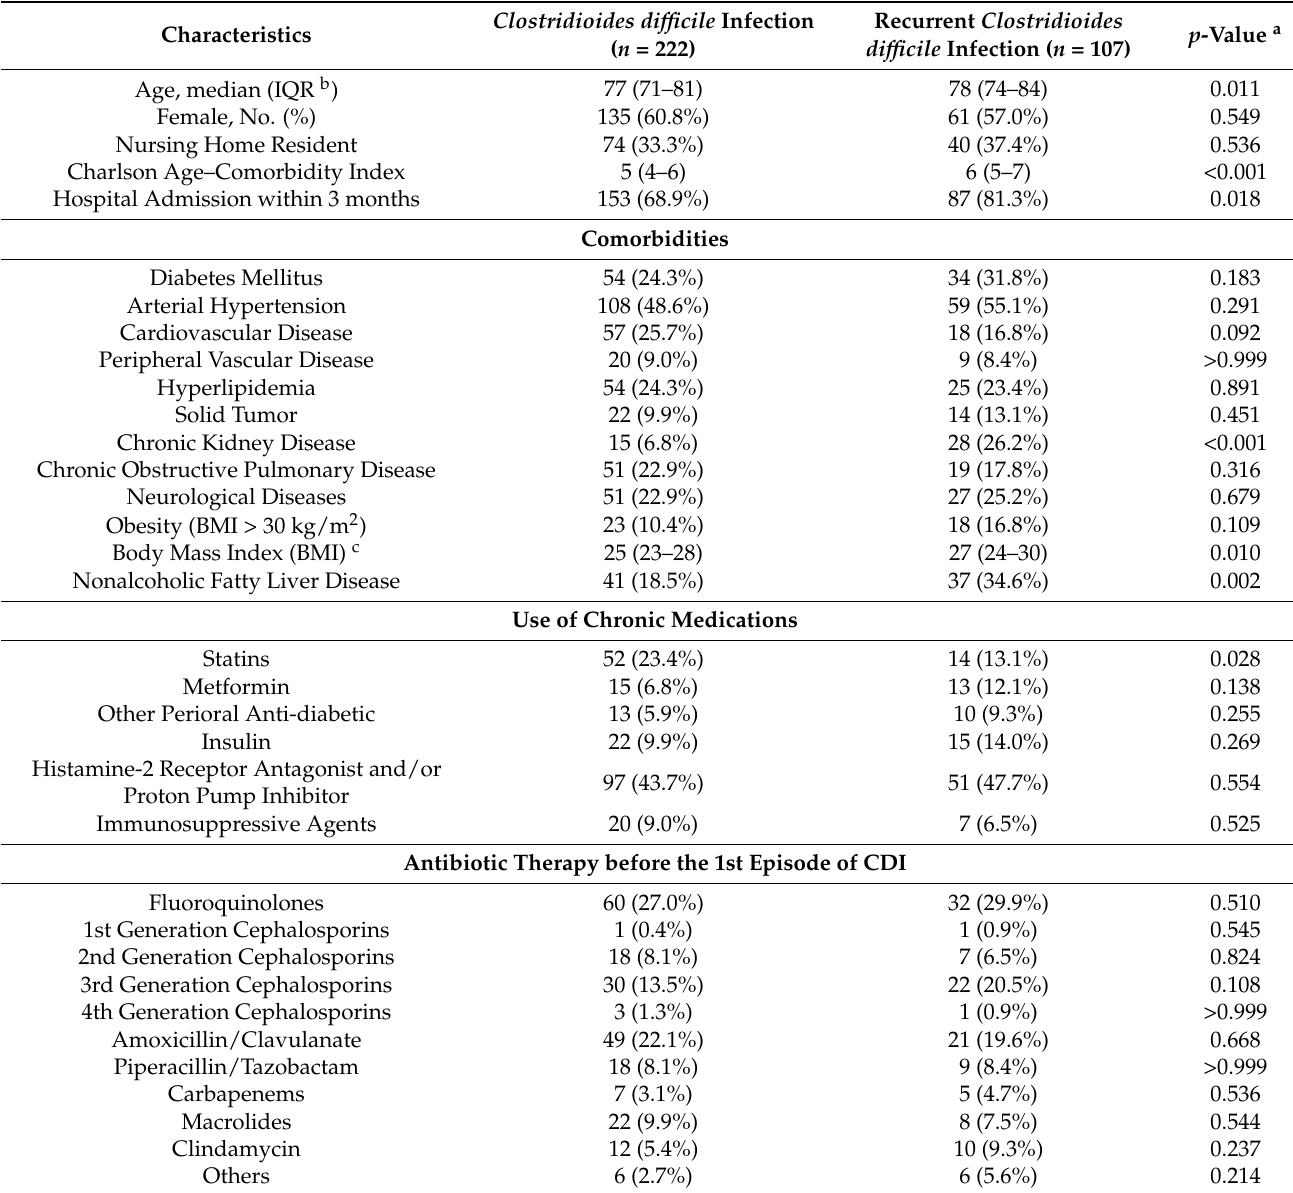
Table 1. Baseline patients’